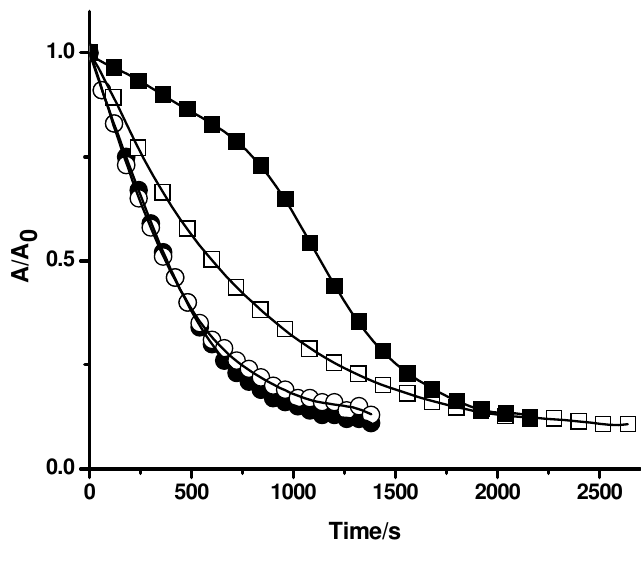
Figure 6. Effect of quercetin (7 µM) on the consumption of PGR (5 µM) induced by AAPH derived peroxyl radicals in the absence ( (cid:2) ) and presence of Triton X-100 micelles ( (cid:2) ). Control experiments without quercetin were carried out in the presence ( (cid:1) ) and absence ( (cid:1) ) of Triton X-100